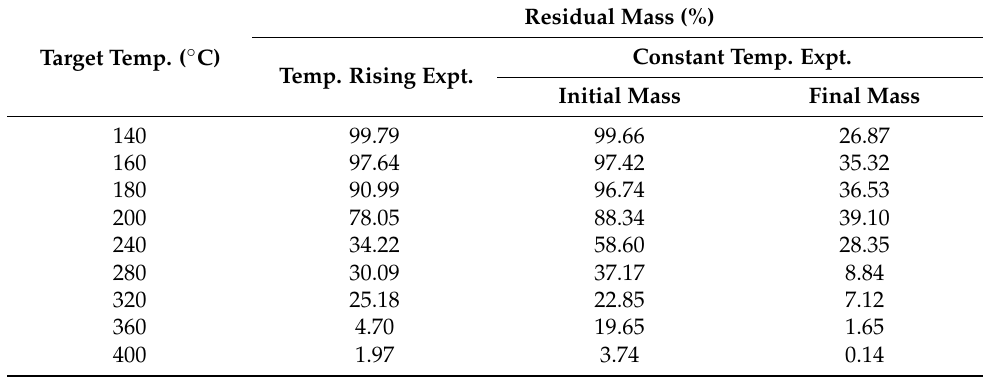
Table 1. Residual mass corresponding to different target